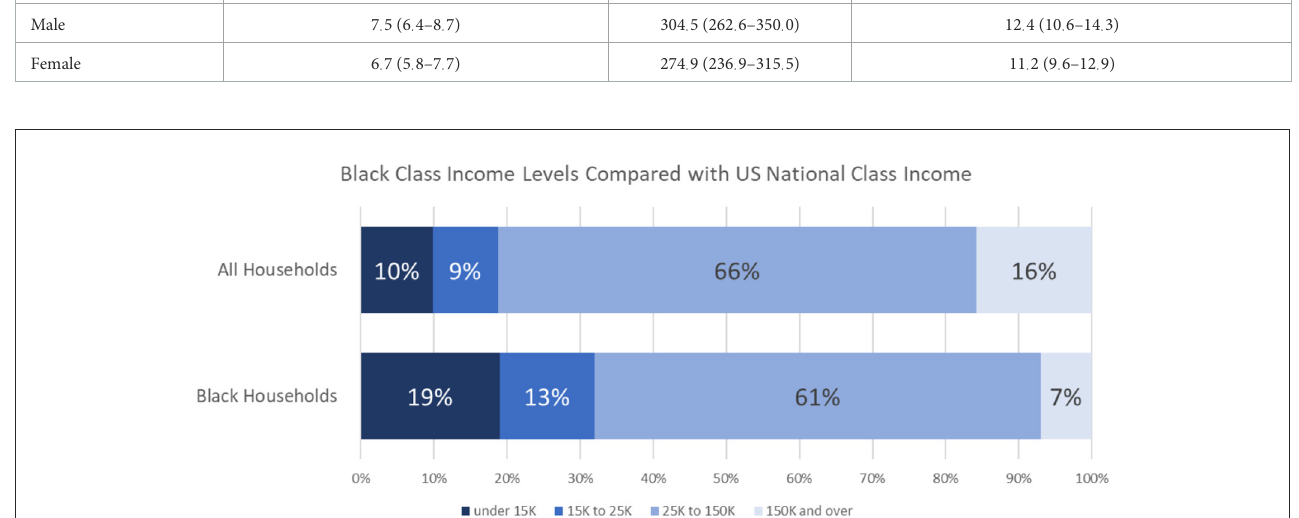
FIGURE1 Socioeconomic class of Black households in the United States as compared with national class